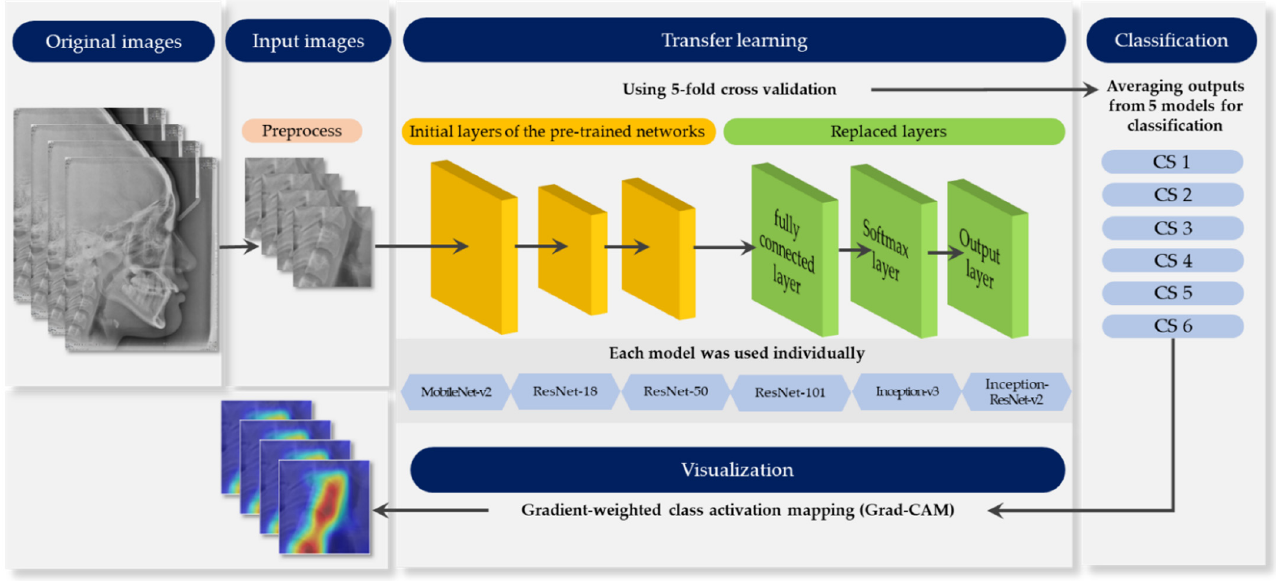
Figure 1. Schematic diagram representing the whole process.